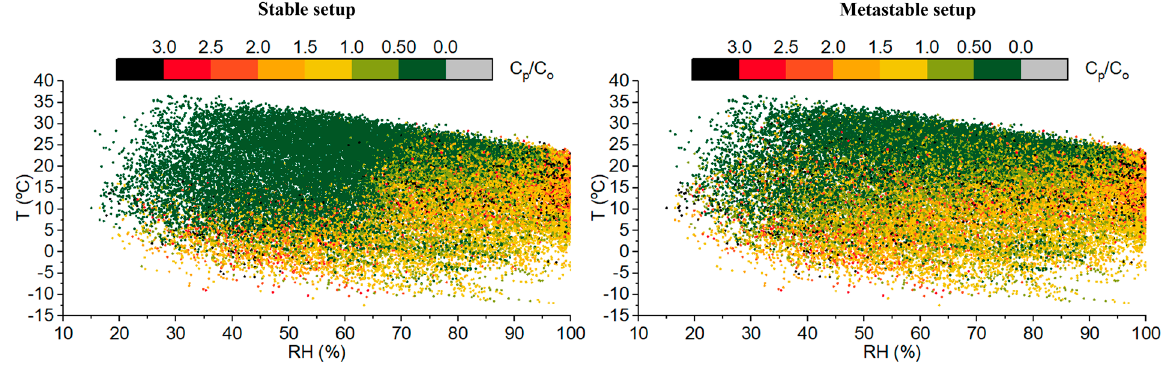
Figure 4. The ratios of C p /C o for NO 3 − using stable and metastable model setups.